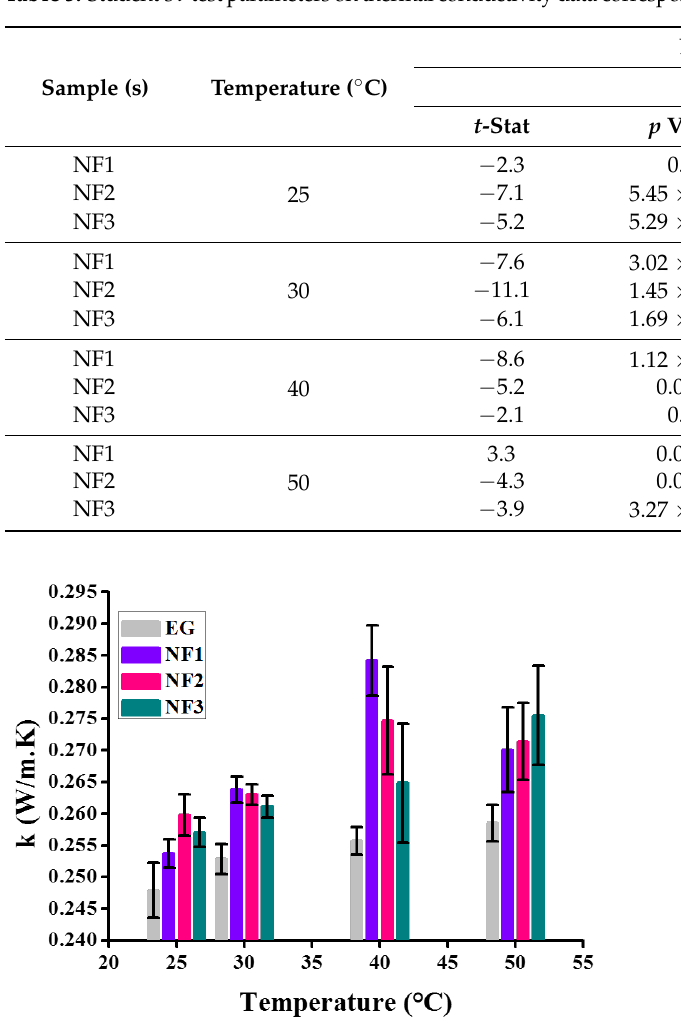
Table 5. Student’s t -testparametersonthermalconductivitydatacorrespondingto95%confidence interval.